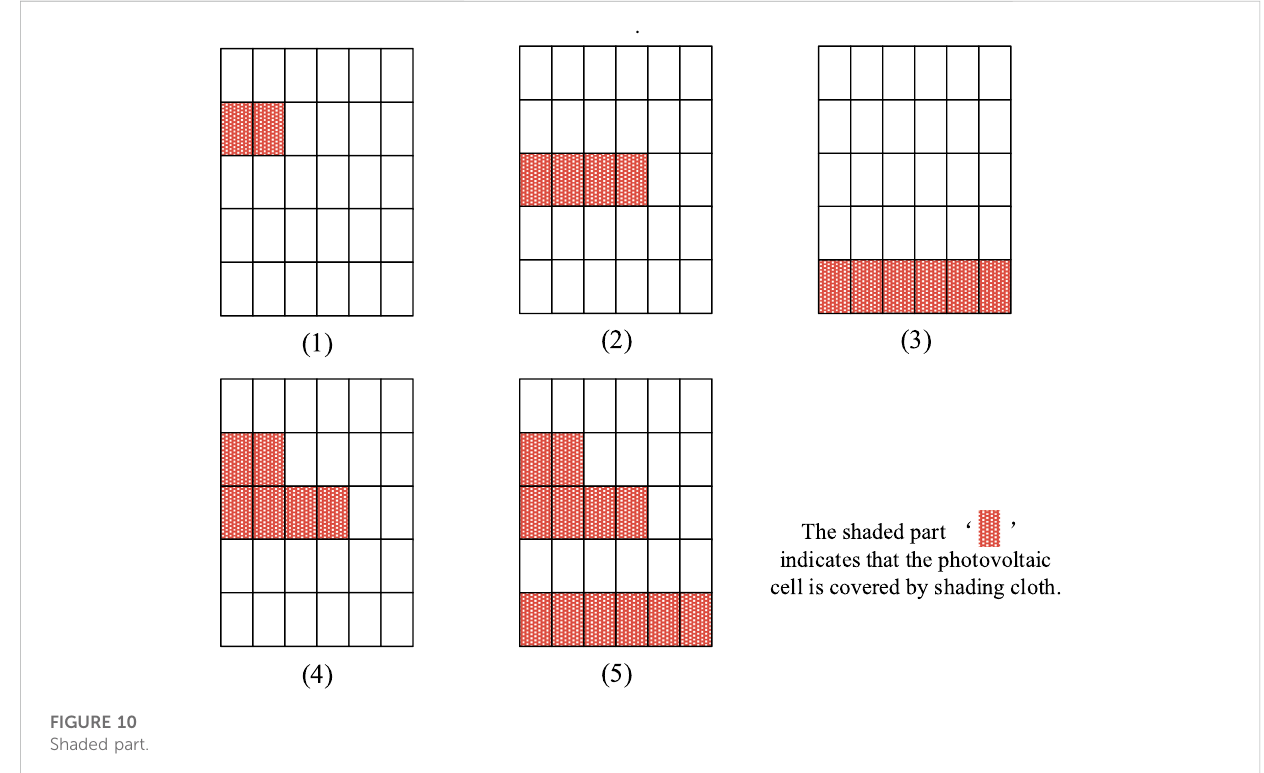
FIGURE 10 Shaded part.